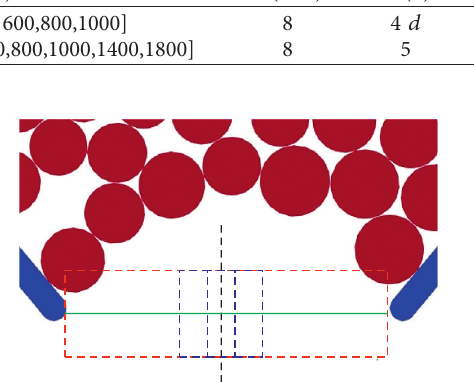
Figure 3: Snapshot of a typical clogging arch. Red (green) box (line) shows the position where the volume fraction and velocity are determined. Blue box is centered at a position x , and it shows where we determine the volume fraction and velocity at the position x